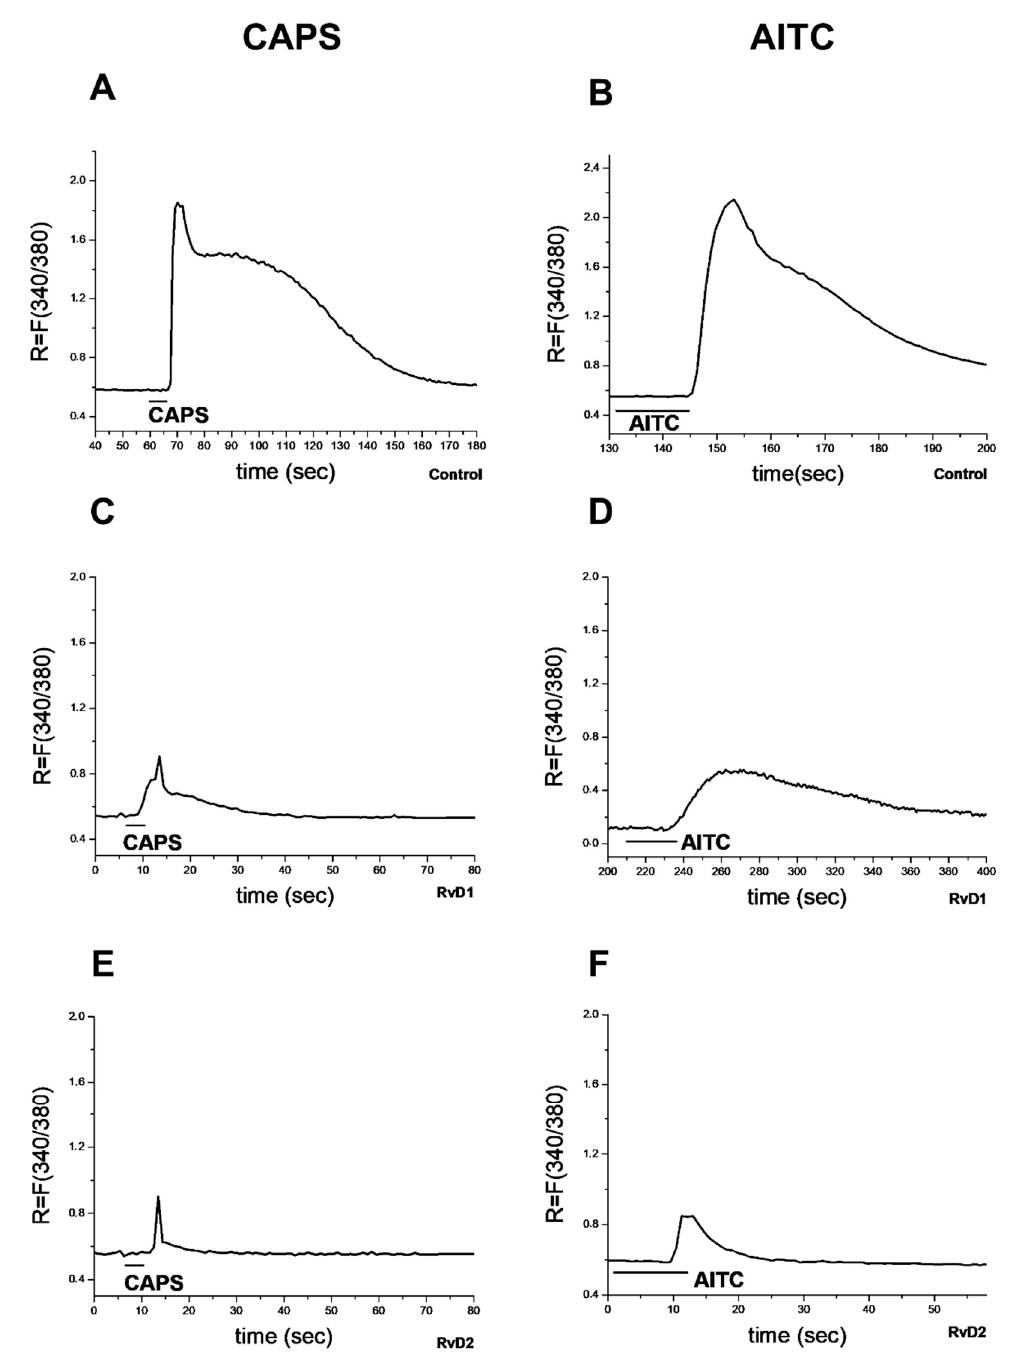
Figure 3. Effect of RvD1 and RvD2 on TRPV1 and TRPA1 receptor activation on cultured TG sensory neurons. Increases in R = 340 / 380 fluorescence in fura-2 loaded cultured TG neurons. Original recording from CAPS ( A , C , E )- and AITC ( B , D , F )-sensitive neurons on control ( A , B ), RvD1-treated ( C , D ) or RvD2-treated ( E , F ) plates.